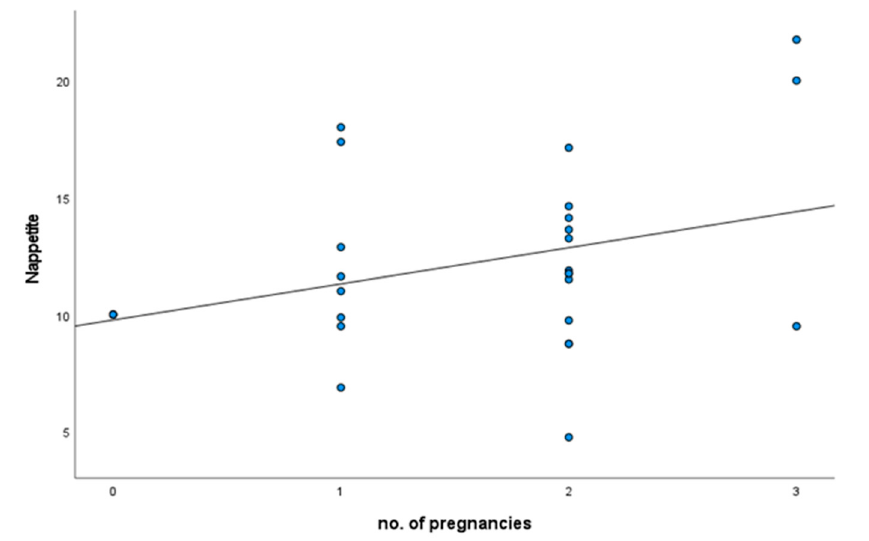
Figure 4. Salt appetite by number of pregnancies.